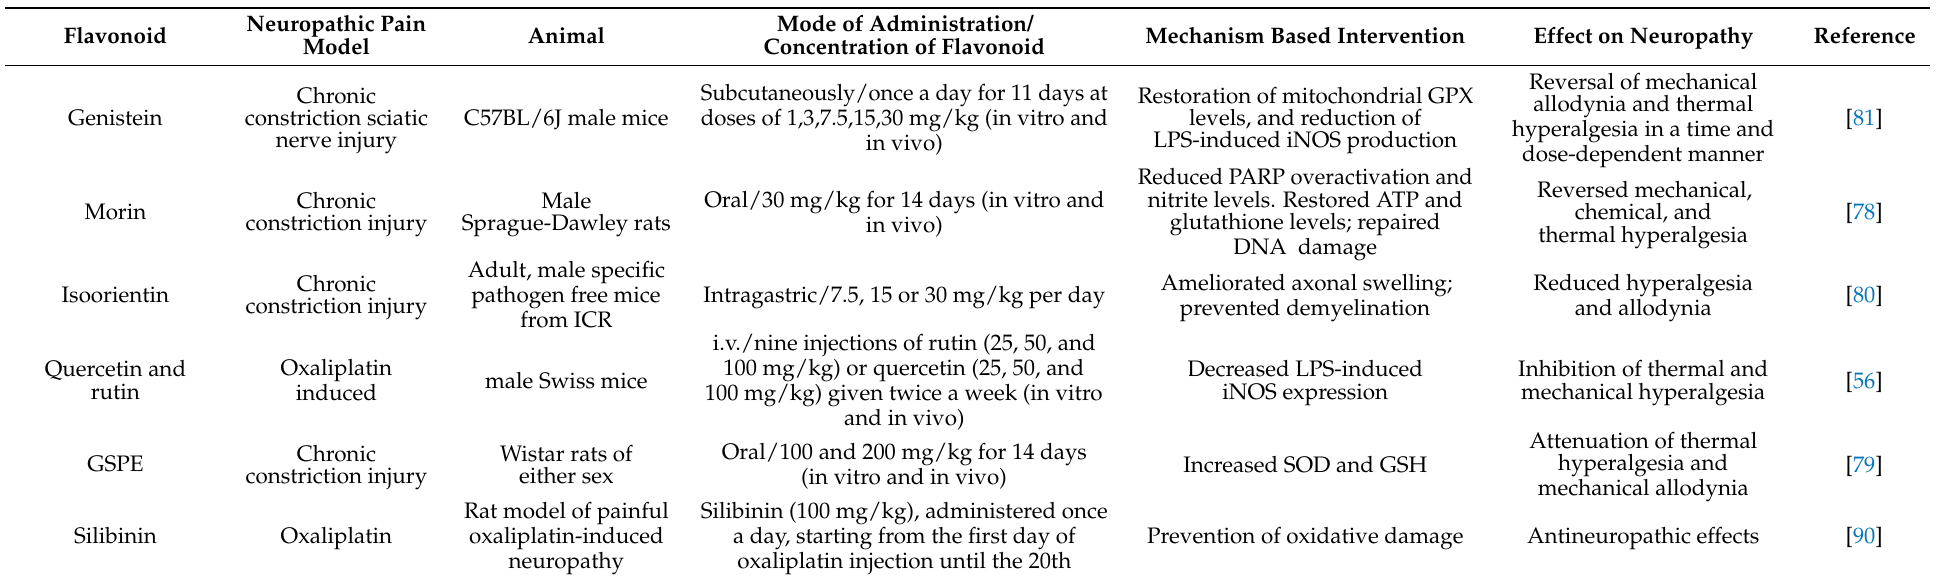
Table 10. Previous studies investigating the effects of flavonoids on CIPN